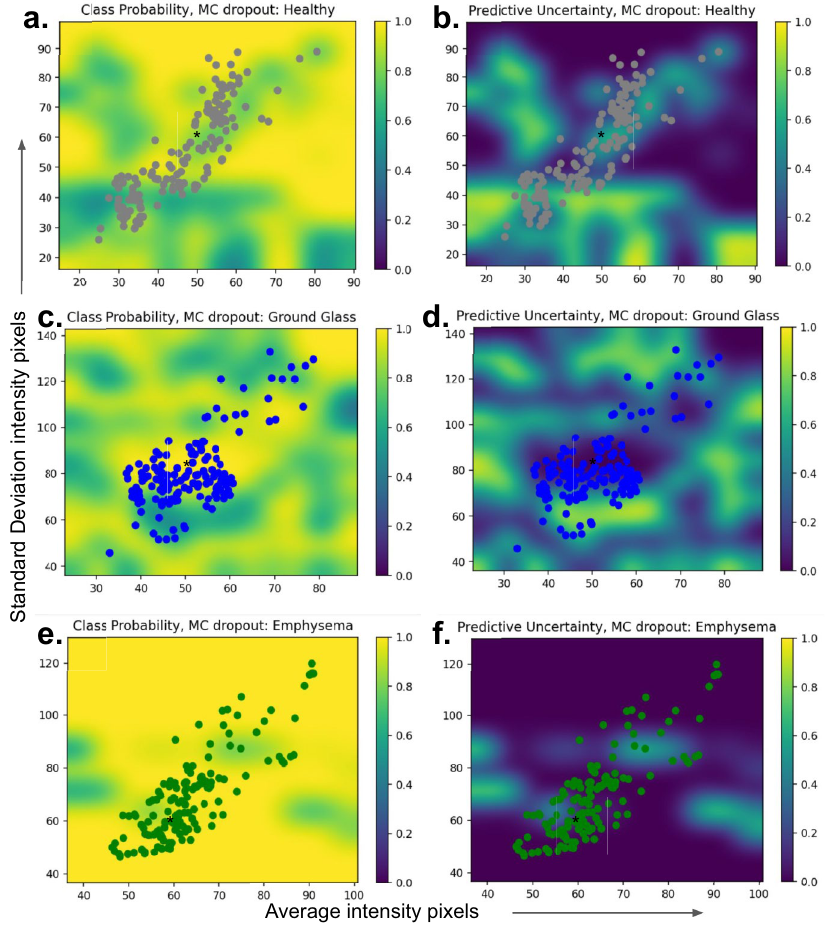
Figure 9. The epistemic and aleatoric uncertainty profile of the ‘seen’ testing dataset of each class for the DenRes-131 deep learning network. ( a – l ) The normalized class probability and predictive uncertainty (epistemic uncertainty) of each class. Each patch image class presented by a different colour circle (patch size of 32 × 32 × 3 ) with respect of the average and standard deviation of the intensity pixels. ( m , n ) the box and Whisker plots results of the epistemic ( m ) and aleatoric ( n ) uncertainty for each